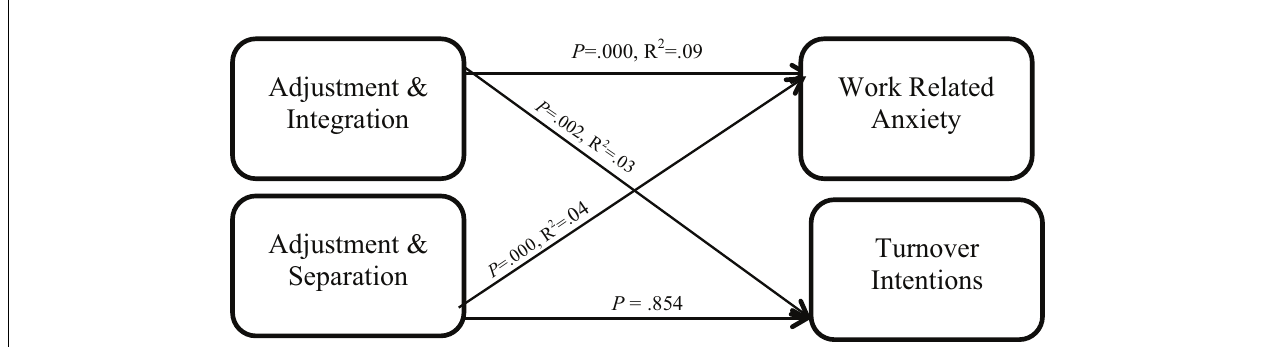
FIGURE 4 | Moderation interaction for school-to-work